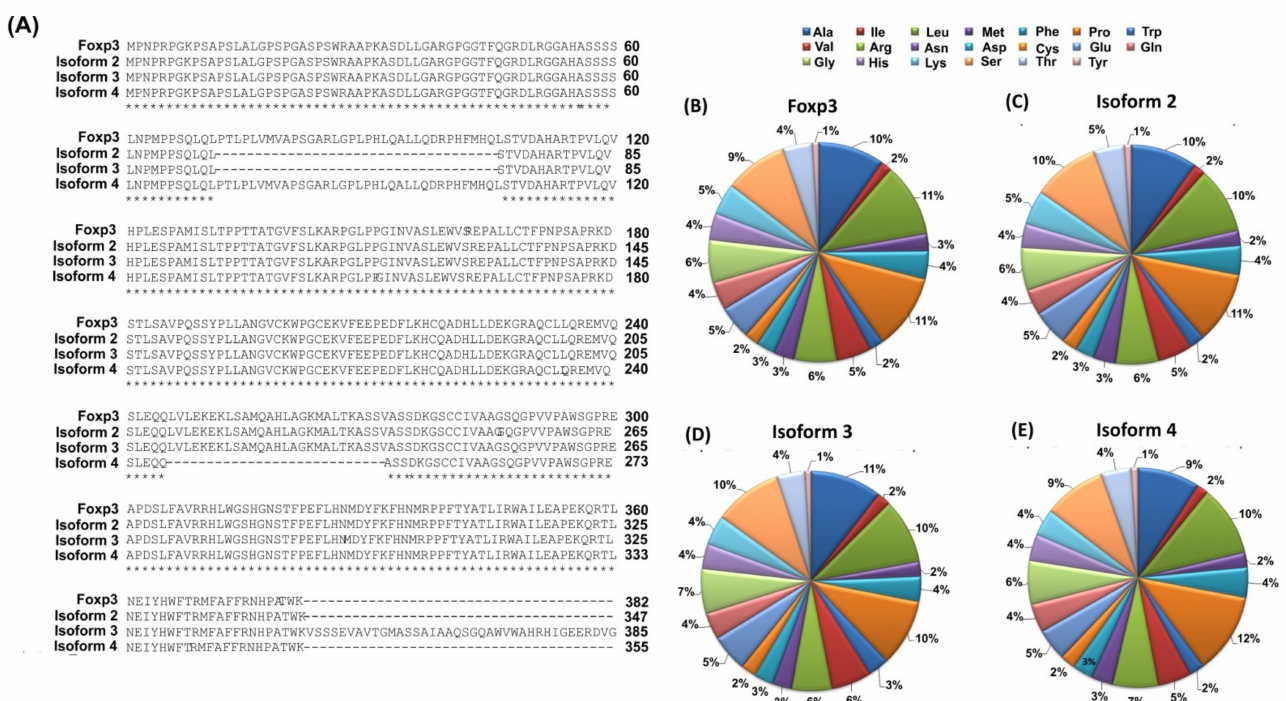
Figure 1. Characterization of the amino acid sequence of the Foxp3 protein and its isoforms ( A ) Com- parison of the amino acid sequence of the Foxp3 protein and its isoforms; ( B – E ) Amino acid scald of Foxp3 protein and its isoforms [own elaboration]. Marks: (*) means the amino acids are identical in the sequence, while (-) means the lack of amino acids in the sequence.